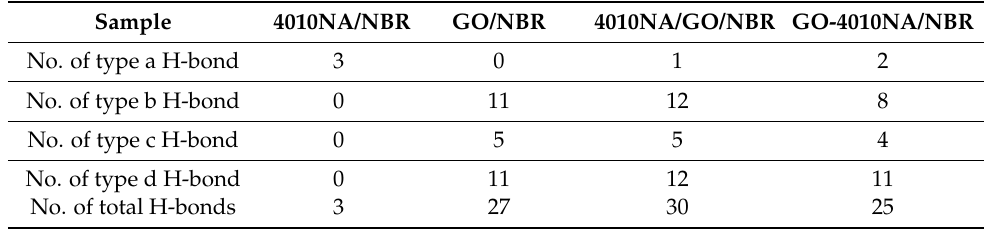
Table 5. Numbers of H-bonds in NBR composites.